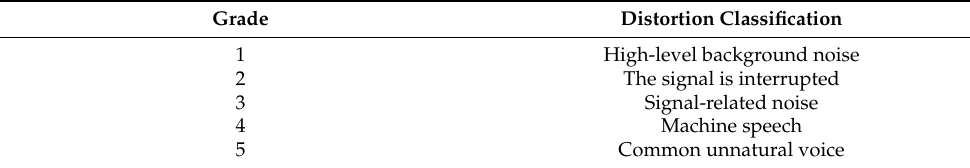
Table 3. P.563 distortion evaluation.